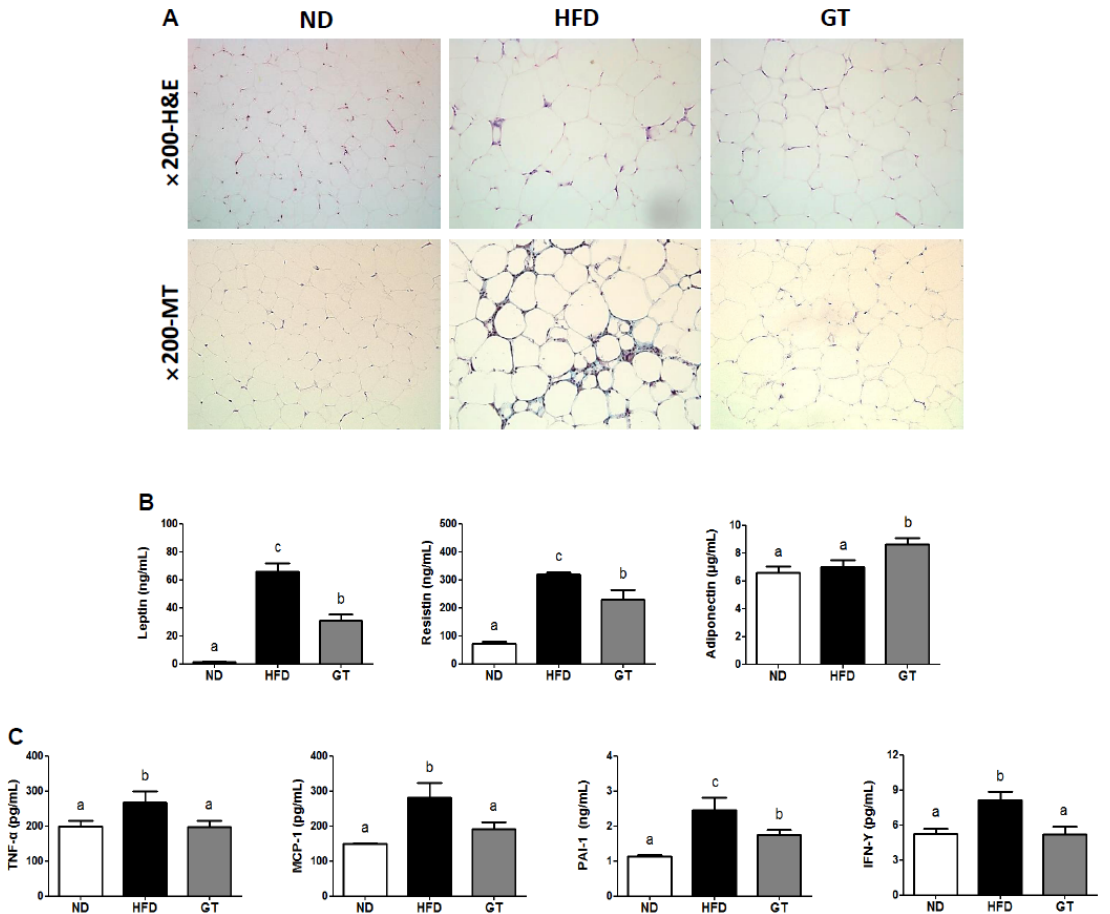
Figure 3. ( A ) Hematoxylin and eosin staining (H & E; upper panel) and Masson’s trichrome staining (MT; lower panel) of epididymal adipocytes (magnification 200×); and ( B , C ) differences in plasma adipokines in diet-induced obese C57BL/6J mice treated with green tea extract for 12 weeks. The data are shown as mean ± standard error of the mean. a–c Mean values not sharing a common superscript were significantly different among the groups ( p < 0.05). ND, normal diet, AIN-93G; HFD, high-fat diet, 60% kcal from fat; GT, green tea extract, 0.25% w / w .